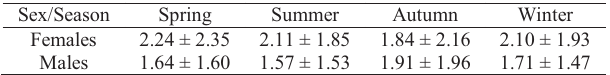
Table 1. Seasonal Stomach Repletion Index (SRI) (mean ± SD) by sex of Acestrorhynchus pantaneiro in the upper Uruguay River.